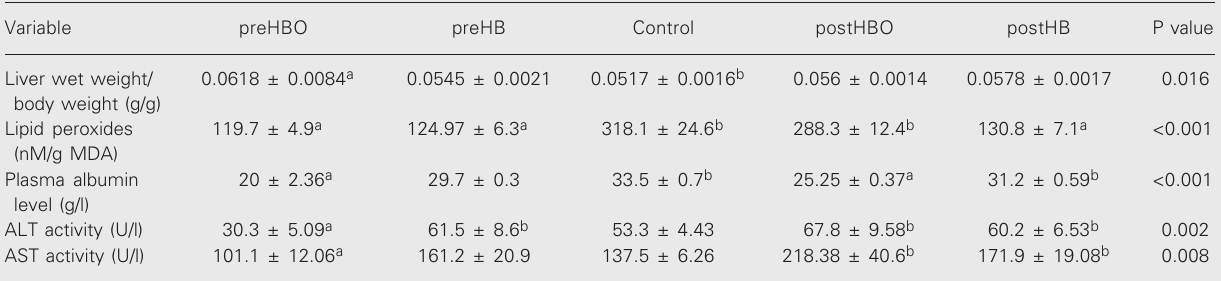
Table 1. Ratio of the wet weight of the remnant liver lobes to body weight, level of lipid peroxides in liver tissue expressed as malondialdehyde (MDA) equivalents, plasma albumin levels, and ALT and AST activity.